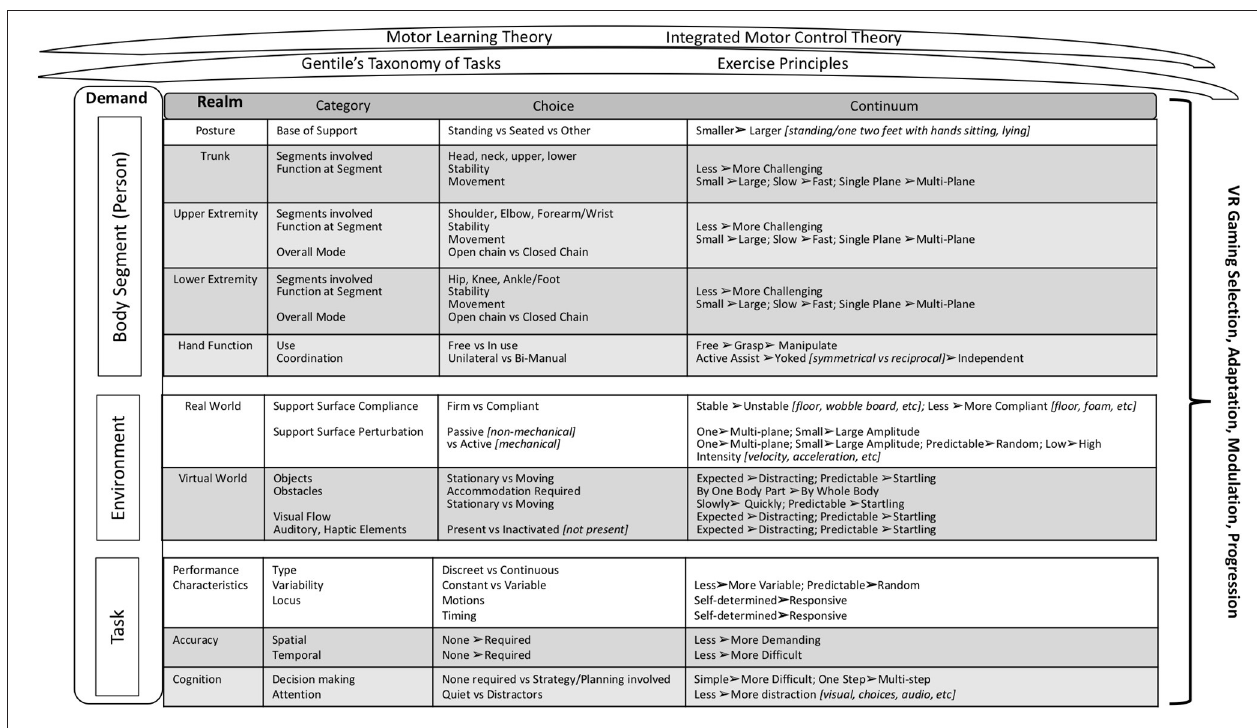
FIGURE 1 | Clinical Decision Making Framework. The framework synthesizes motor learning and control and exercise science considerations as encountered in the use of VR or gaming technologies as a therapeutic training modality in rehabilitation. It is portioned into demands based on the person (body segment), the environment, and the tasks. The realms specify the potential areas to consider within each type of demand; and the category breaks down each realm into the motor learning, motor control, or exercise-based elements presented within that realm. Within each category, the difficulty of the motor control, motor learning, or exercise element presented can be modulated through discreet choices (Choice) and/or by increasing or decreasing the parameters indicated within